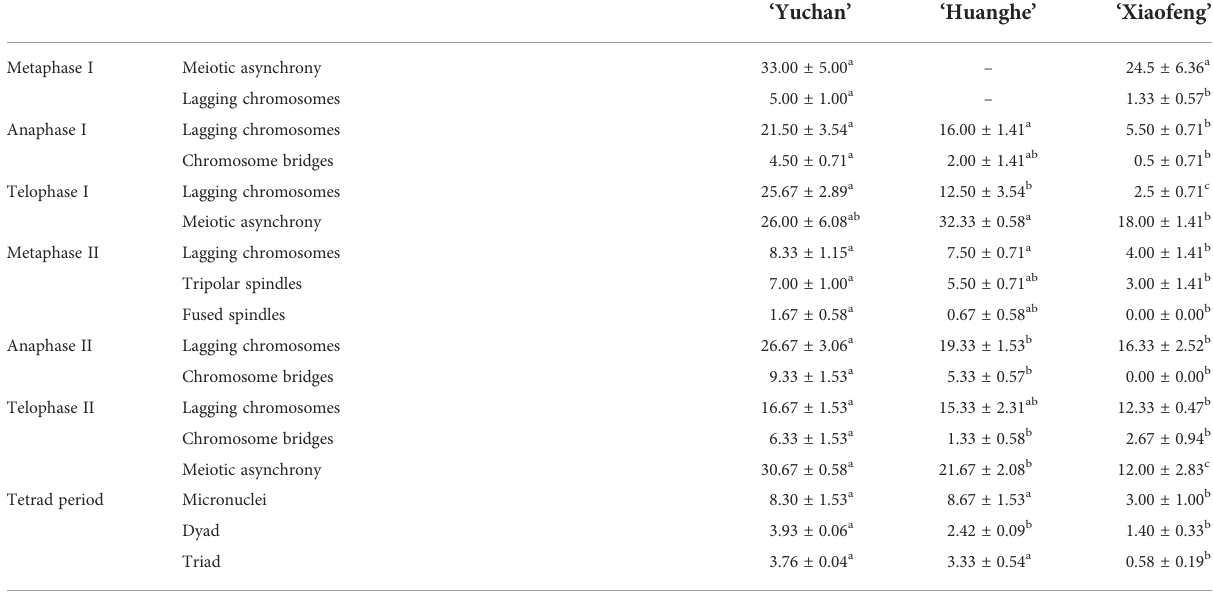
TABLE 4 Meiotic abnormalities in cymbidium ‘ Yuchan ’ , ‘ Huanghe ’ , and ‘ Xiaofeng ’ . Stage